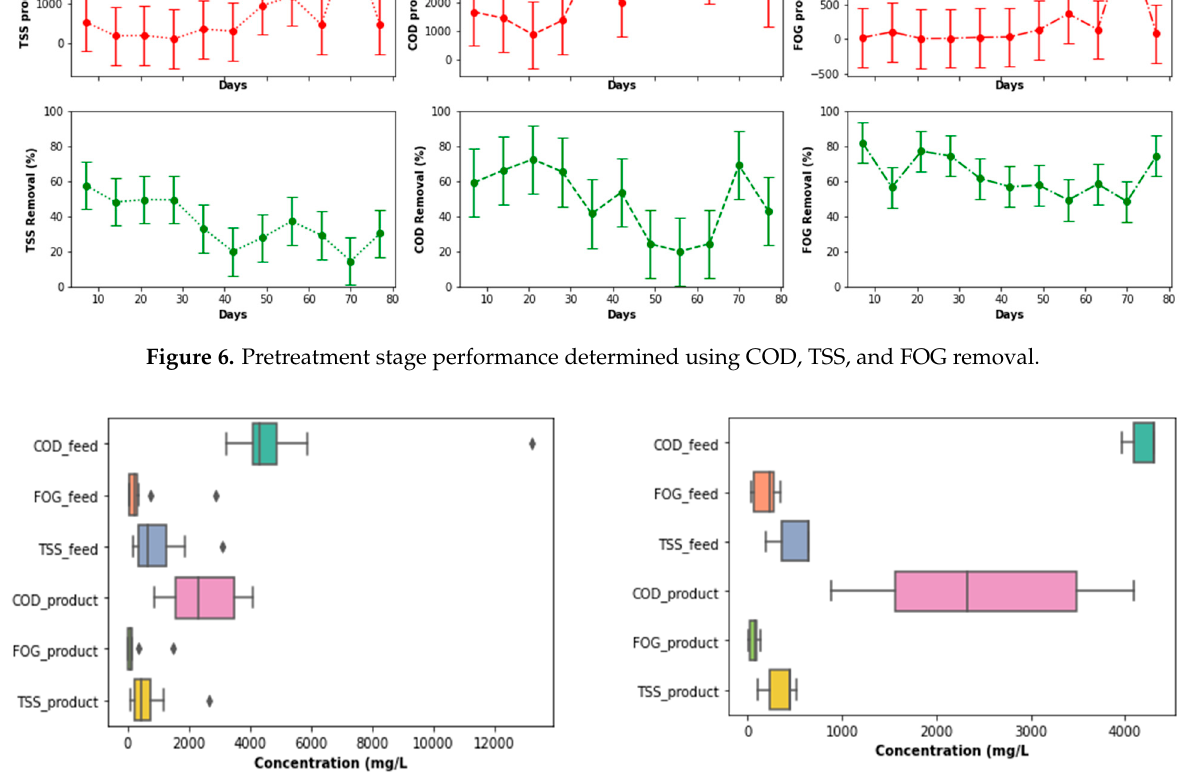
Figure 8 . Pretreatment stage performance assessed using COD, TSS, and FOG concentration removal. 3.2. Expanded Granular Sludge Bed Reactor (EGSB) Performance Before evaluating the performance of the EGSB in terms of COD, TSS, and FOG re- moval, as displayed in Figure 9, a boxplot of these values was plotted to visually detect possible outliers. The interest was specifically in the product stream generated from the